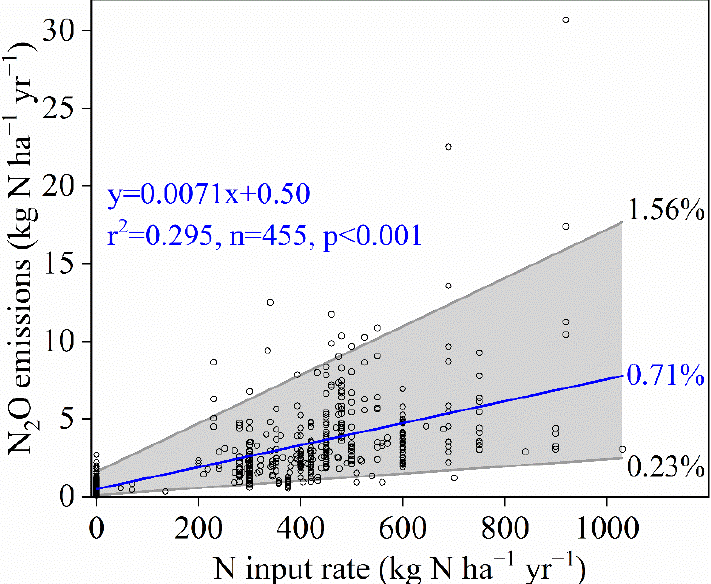
Figure 2. Relationship of N 2 O emissions (kg N ha − 1 yr − 1 ) against N input rates (kg N ha − 1 yr − 1 ) in winter wheat–summer maize rotation. The stick line and model are fitted to all data points following ordinary least squares regression. The bottom and top edges of the gray area are the estimated regressions at the 5% and 95% quantile levels, respectively.